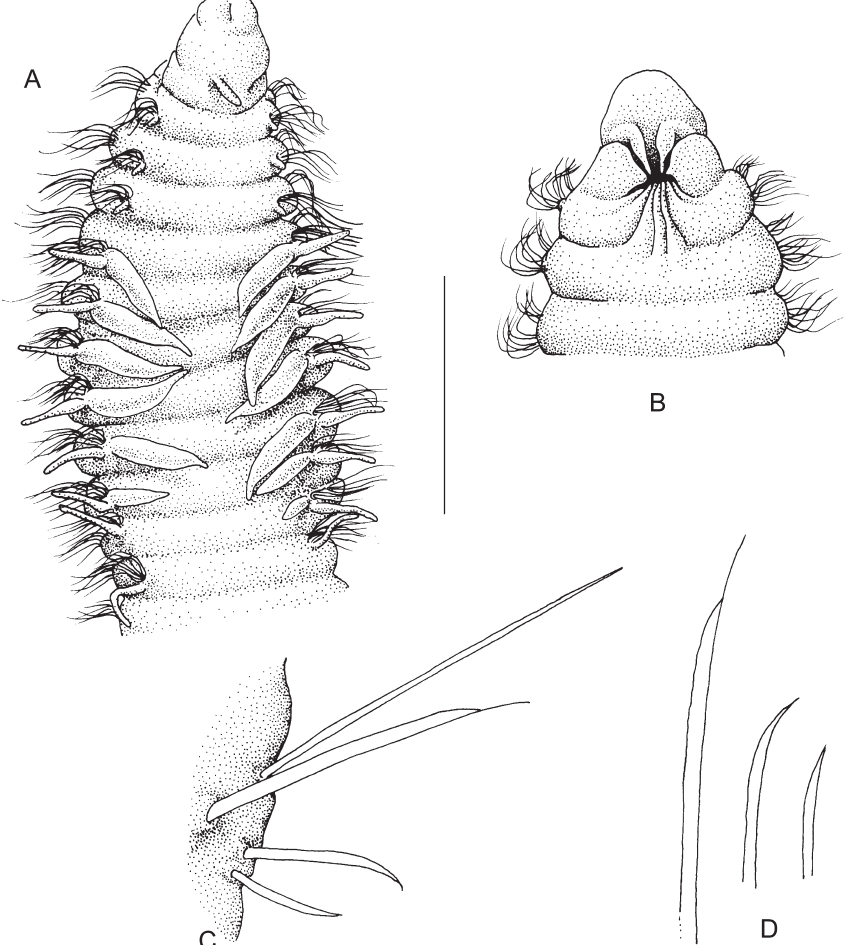
Fig . 17. – Aricidea ( Allia ) monicae : A, anterior region, dorsal view; b, anterior region, ventral view; c, neuropodium, chaetiger 44; D, modi- fied ventral chaeta, chaetiger 44. Scale bar: A 470 µ m; b 455 µ m; c 90 µ m; D 70 µ Table 4. The main morphological characters, inter- parapodial lobes included, resemble those of Arici­ dea ( Allia ) monicae , but can be distinguished by its bifurcated median antenna, very similar to the anten- nae of Aricidea ( Allia ) mediterranea and Aricidea ( Aricidea ) petacalcoensis (see the remark section under Aricidea ( Allia )). Distribution . capbreton canyon, bay of biscay, 492 to 495 m depth.